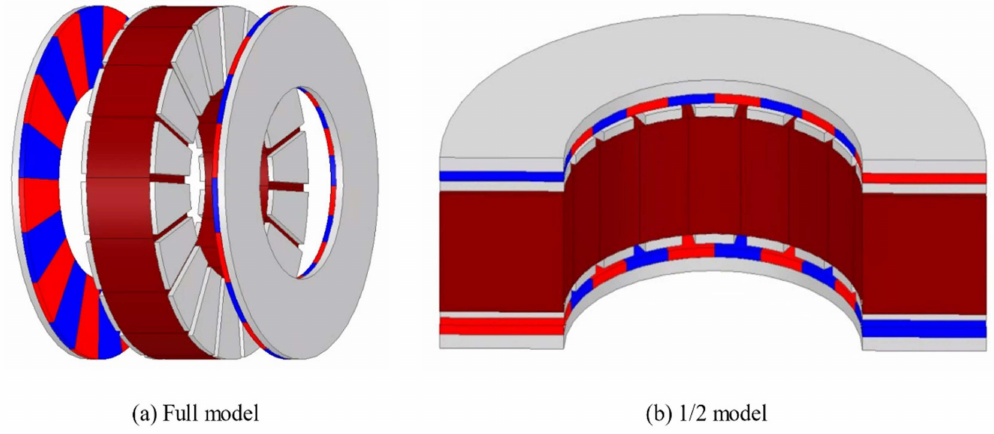
Figure 12. Shape of DRAFPM